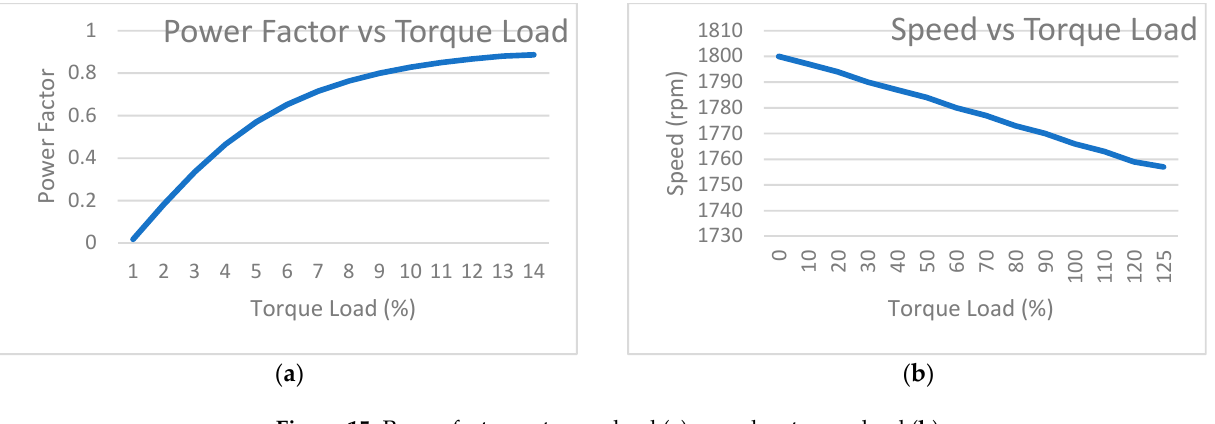
Figure 15. Power factor vs torque load ( a ); speed vs torque load ( b ).